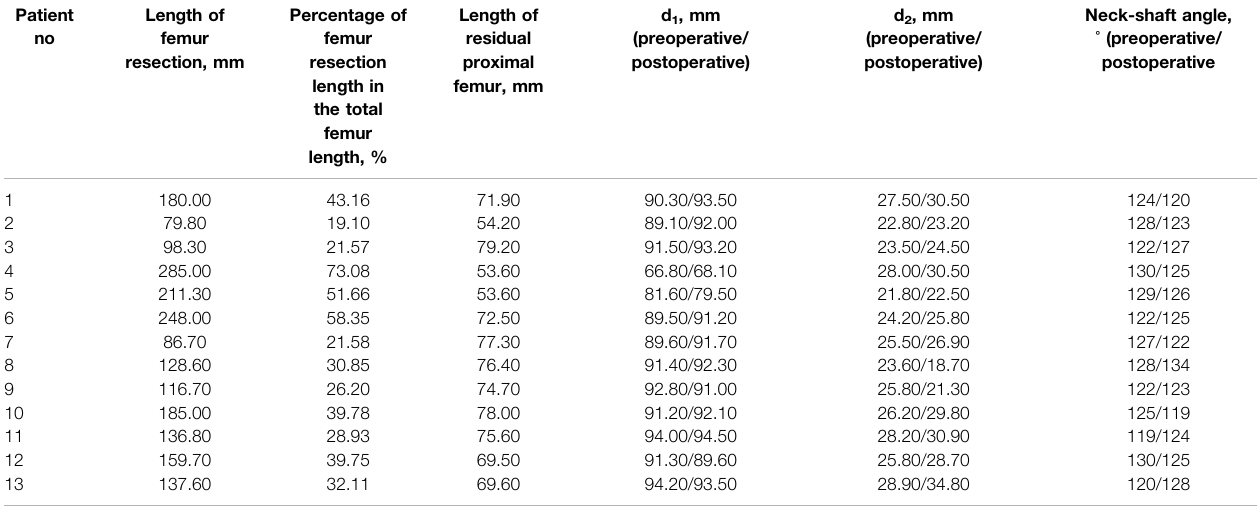
TABLE 2 | Details of the surgical technique and INCS location evaluation. Patient Length of no femur resection, mm